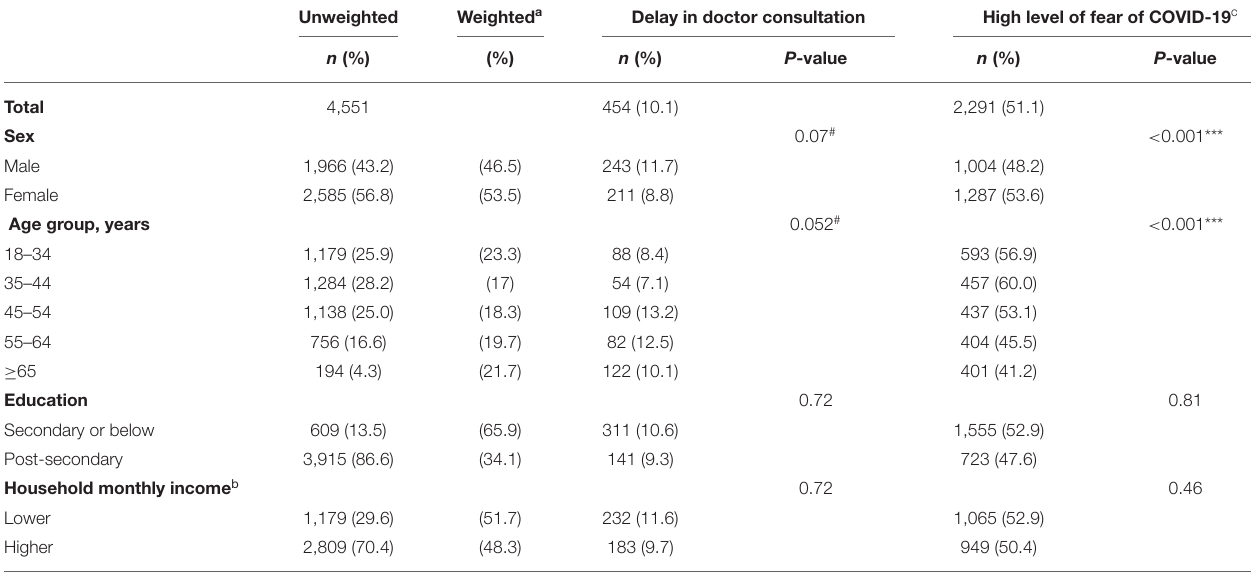
TABLE 1 | Prevalence of delay in doctor consultation by sociodemographic